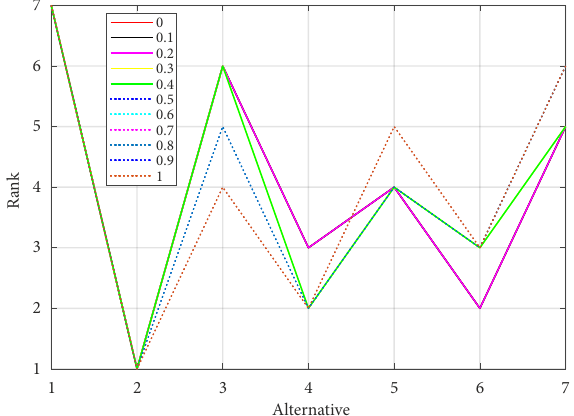
Figure 1. Rankings of alternatives obtained based on different values of